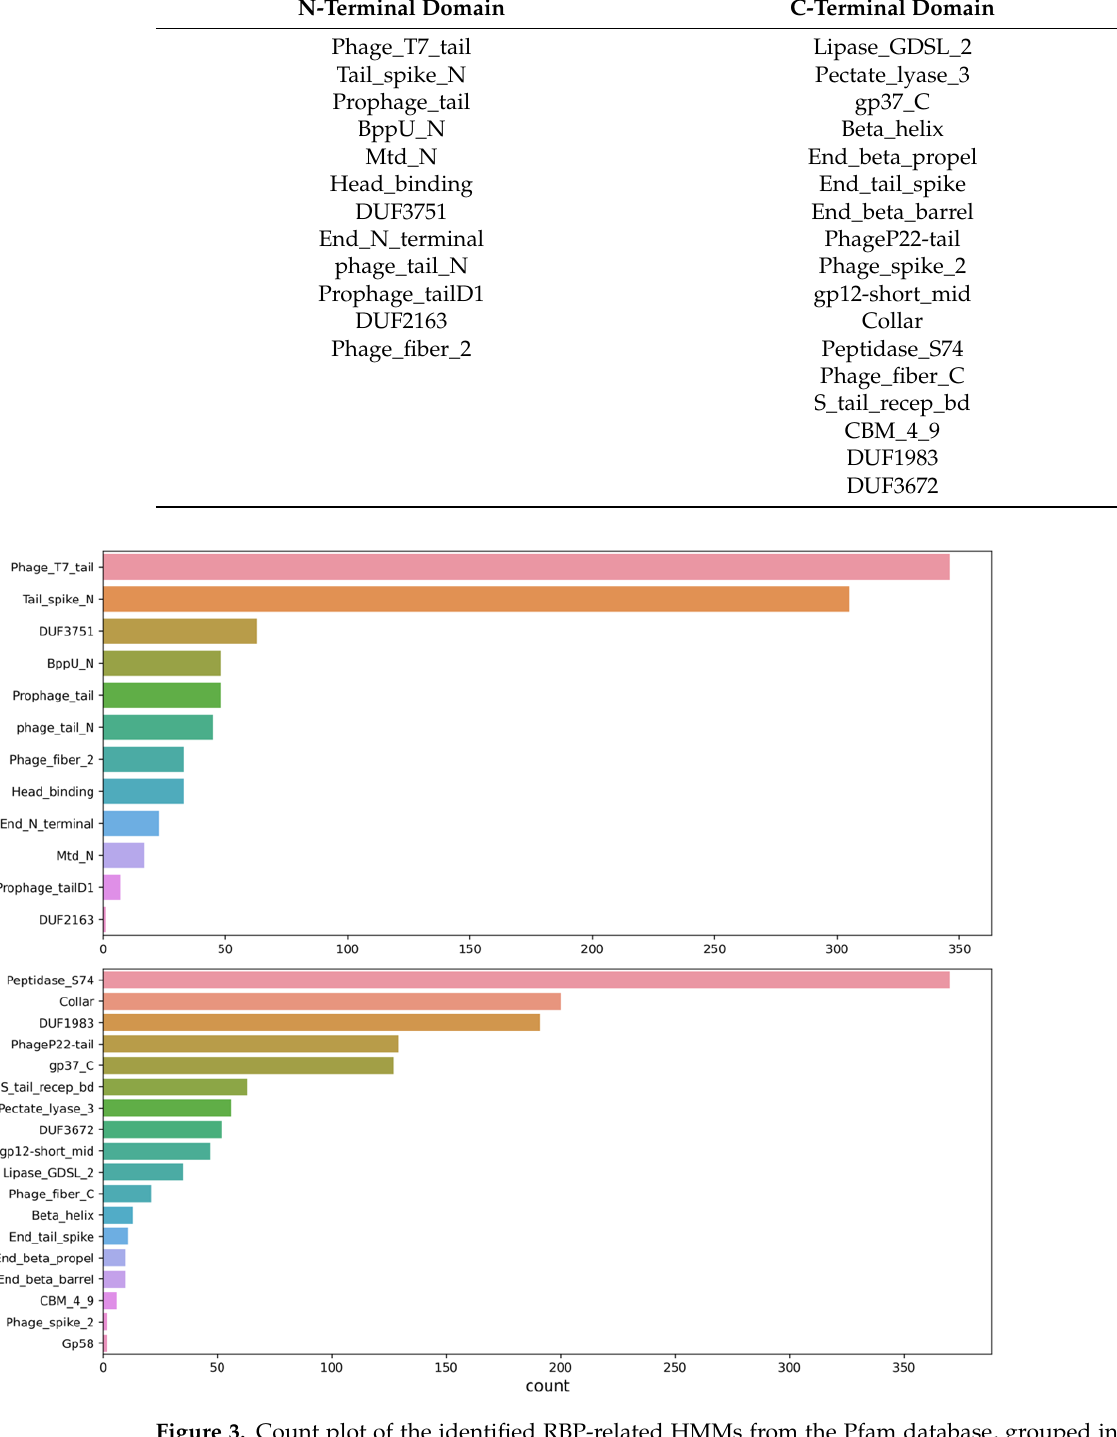
Figure 3. Count plot of the identified RBP-related HMMs from the Pfam database, grouped into N-terminal domains ( top ) and C-terminal domains ( bottom ). At the N-terminus, two domains occur substantially more than all the others (namely Phage_T7_tail and Tail_spike_N ). At the C-terminus, Peptidase_S74 is the most occurring domain. Table 2. RBP-related protein domains collected as HMMs from the Pfam database.